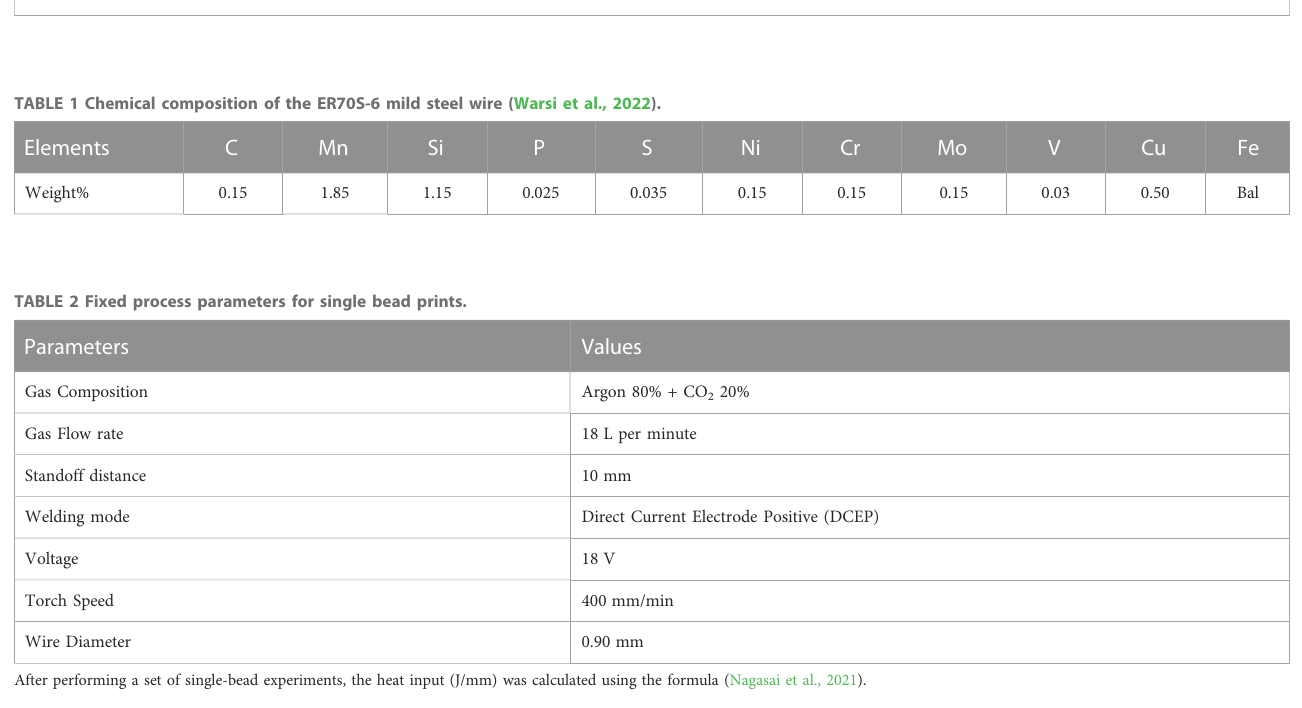
FIGURE 1 (A) Schematicrepresentation, (B) theH-WAAMsetupillustratingthecouplingofaDCwelderandCNCmachinetool, (C) weldingtorchandmillingcutter assembly, and (D) active cooling heat exchanger.